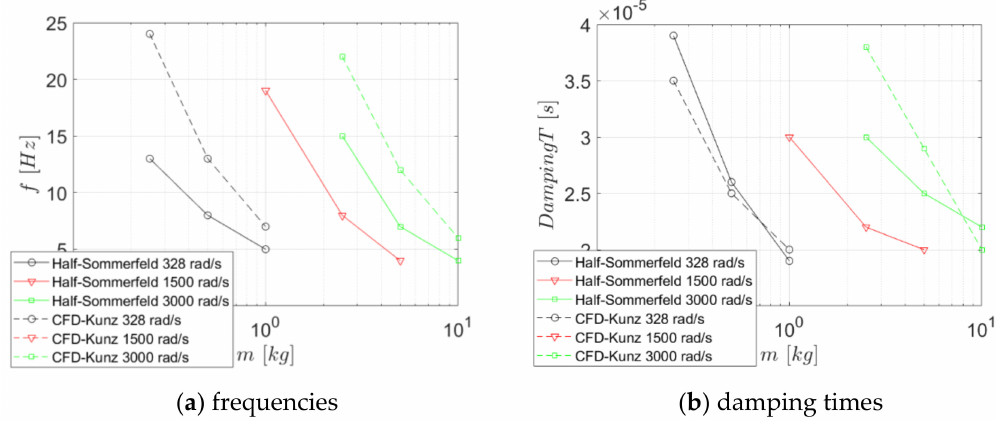
Figure 12. Excitation frequency vs. journal mass ( a ) and damping time vs. journal mass ( b )–Half-Sommerfeld vs.